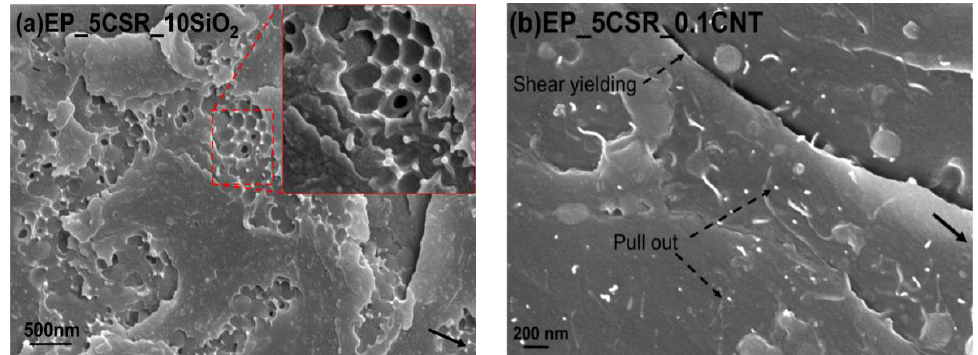
Figure 3. SEM micrographs of the fracture surface of the different reference and modified